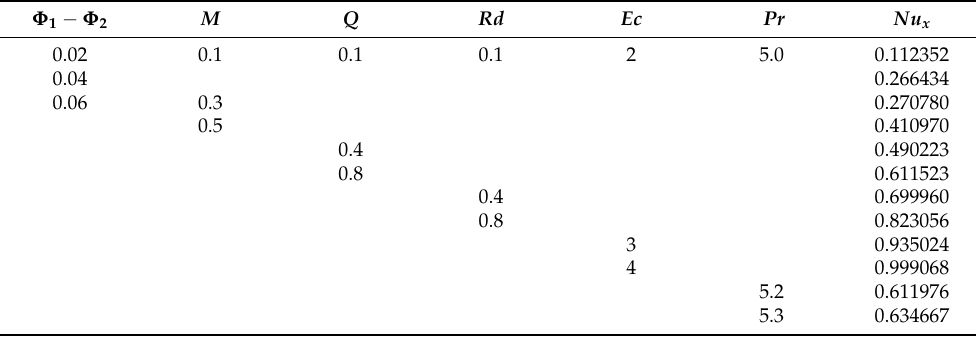
Table 4. Dependence of Nu x Re − 0.5 x on different quantities